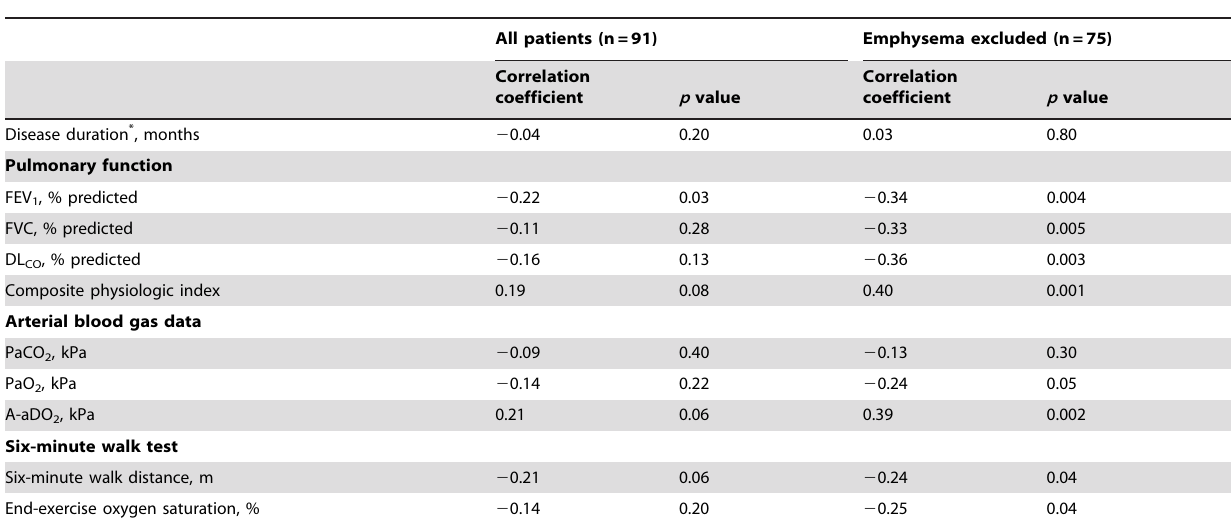
Table 2. Relationships between plasma 15-keto-dihydro prostaglandin F 2 a concentrations and clinical parameters in patients with idiopathic pulmonary fibrosis.